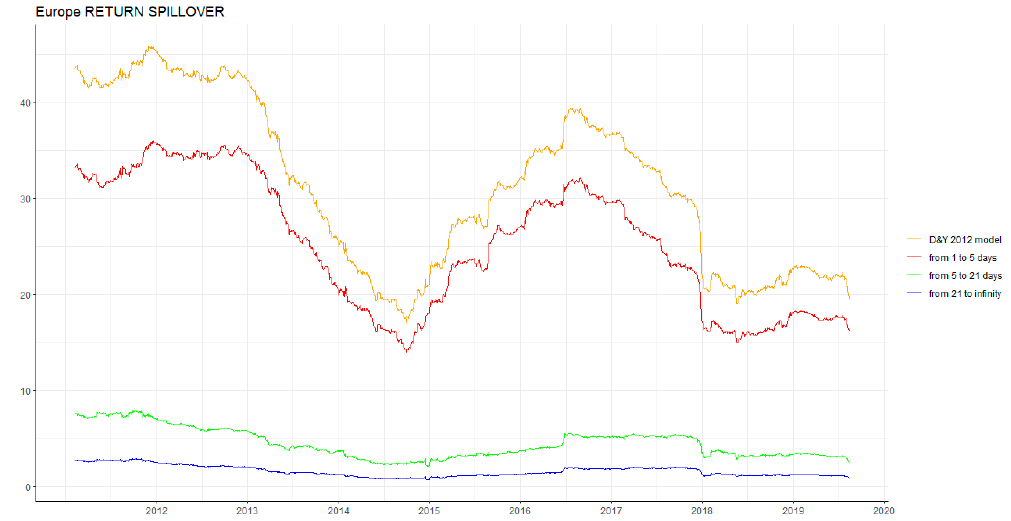
Figure A7. Total return spillover of DY12 and BK18 in Europe (Windows 250).